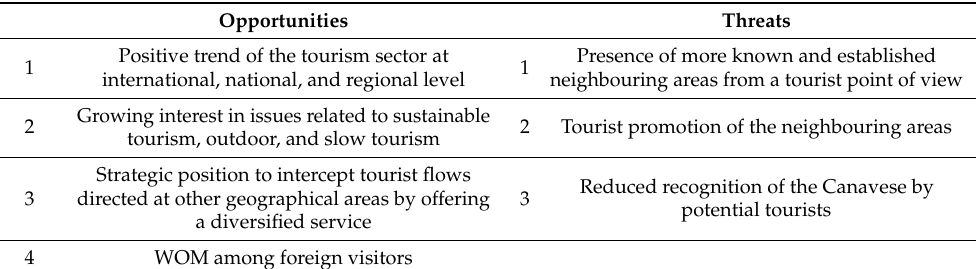
Table 4. Opportunities and threats for tourism in the Canavese